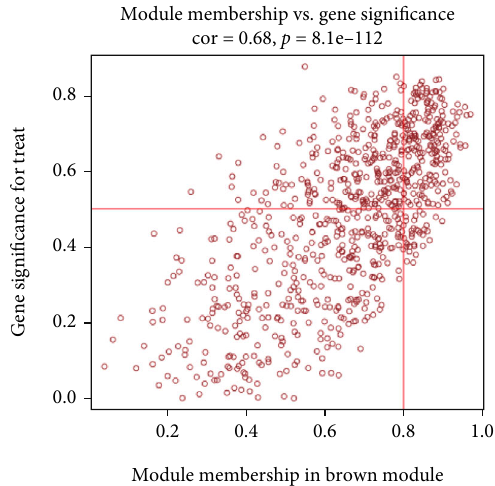
Figure 2: Constructing the WGCNA modules. (a) A cluster dendrogram of the genes having a median absolute deviation in the top 25%. Every branch denotes a single gene, while each color indicates a coexpression module. (b) Heat maps indicating the relationship between the module and trait. The brown module shows a signi fi cant relationship with the carotid atherosclerotic plaques. (c) Distribution of the mean gene signi fi cance in the modules associated with the carotid atherosclerotic plaques. (d) Scatter plots describing the correlation between the gene signi fi cance and gene module membership in the brown module. WGCNA: Weighted Gene Coexpression Network